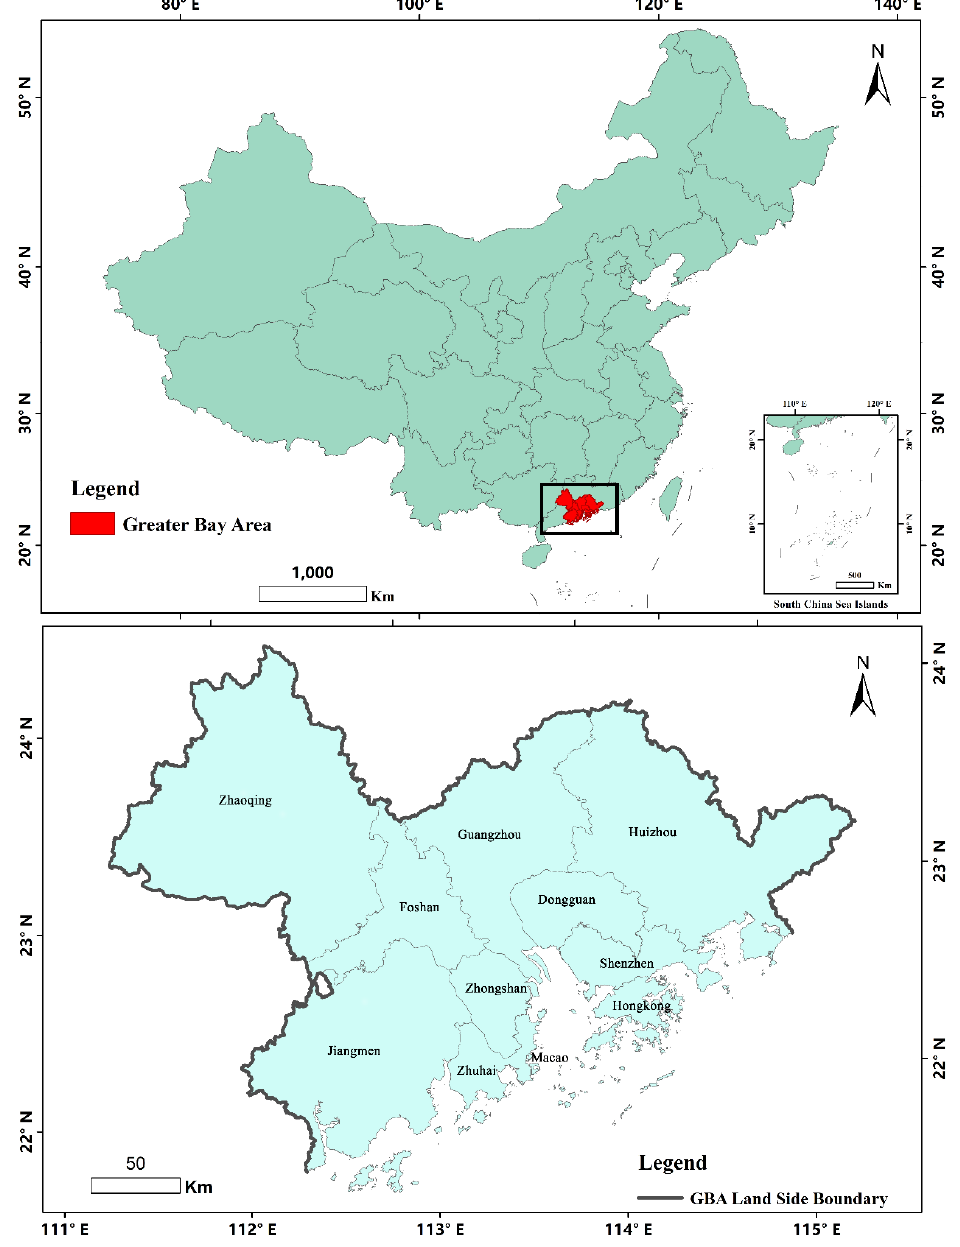
Figure 1. Location of the study area.